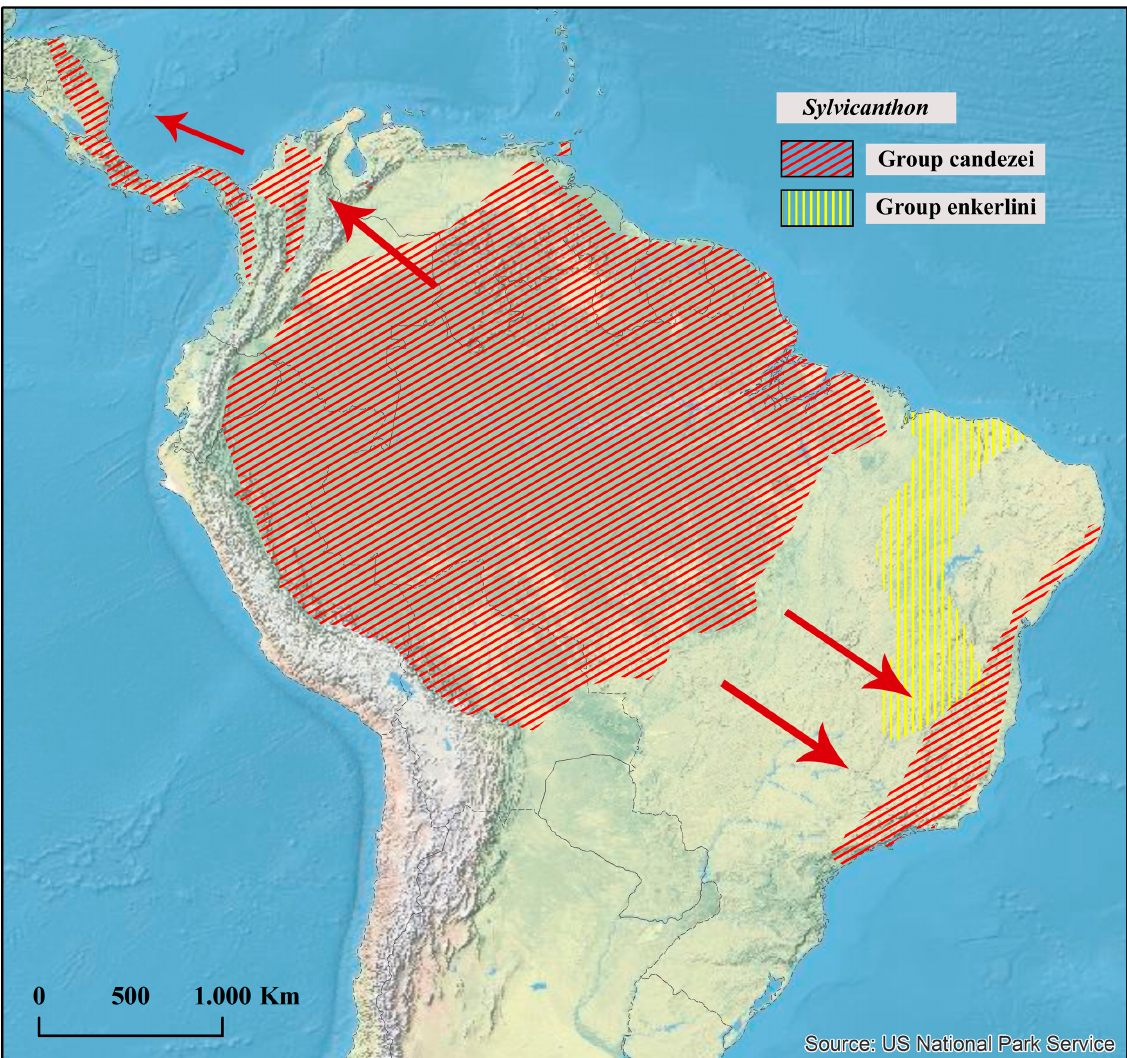
Fig. 20. Combined distribution of the species of Sylvicanthon in the Neotropical region. Note that the genus occupies the four great areas of tropical humid forest of the American continent: Central American forests, the Choco of the South American northwest, the Amazon Rainforest and the Atlantic Forest. Following the hypothesis of Martínez et al. (1964) that the Amazon Basin was the ancestral area of the Sylvicanthon of the candezei group, three lineages have independently dispersed from there (arrows): that of the ancestors of S. aequinoctialis (Harold, 1868), which, from the Choco, invaded Central America at the pace of the tropical forests’ gradual northwards advance, occurred during the Plio-Pleistocene, and those of the ancestors of respectively S. obscurus (Schmidt, 1920) and S. foveiventris (Schmidt, 1920), which reached the Atlantic Forest through the corridors of humid forests that bridged that biome to the Amazon forest during the wettest periods of the Neogene (see a more detailed discussion in the